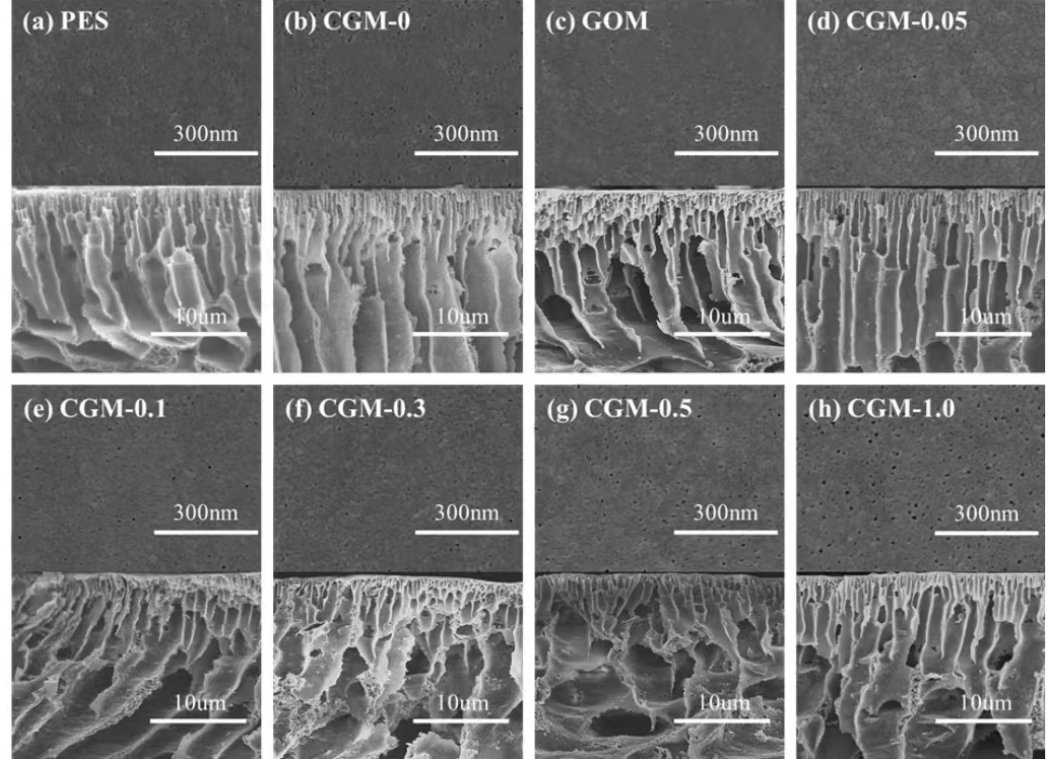
Figure 6. Surface and cross-sectional SEM images of pure PES ( a ), CGM-0 ( b ), GOM ( c ), CGM-0.05 ( d ), CGM-0.1 ( e ), CGM-0.3 ( f ), CGM-0.5 ( g ) and CGM-1.0 ( h ).